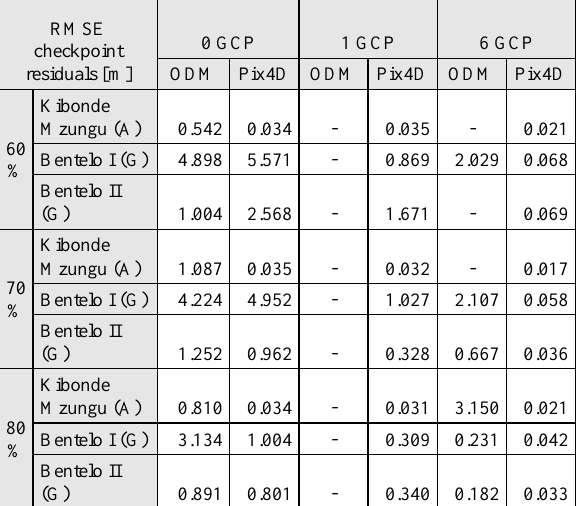
Table 3: Overview of RMSE of checkpoint residuals from controlled experimental UAV flight datasets Kibonde Mzungu, Bentelo I and Bentelo II distinguished by processing software (ODM/Pix4D), different side lap (60%, 70%, 80%), and different GCP scenarios (0 GCP, 1 GCP, 6 GCP).